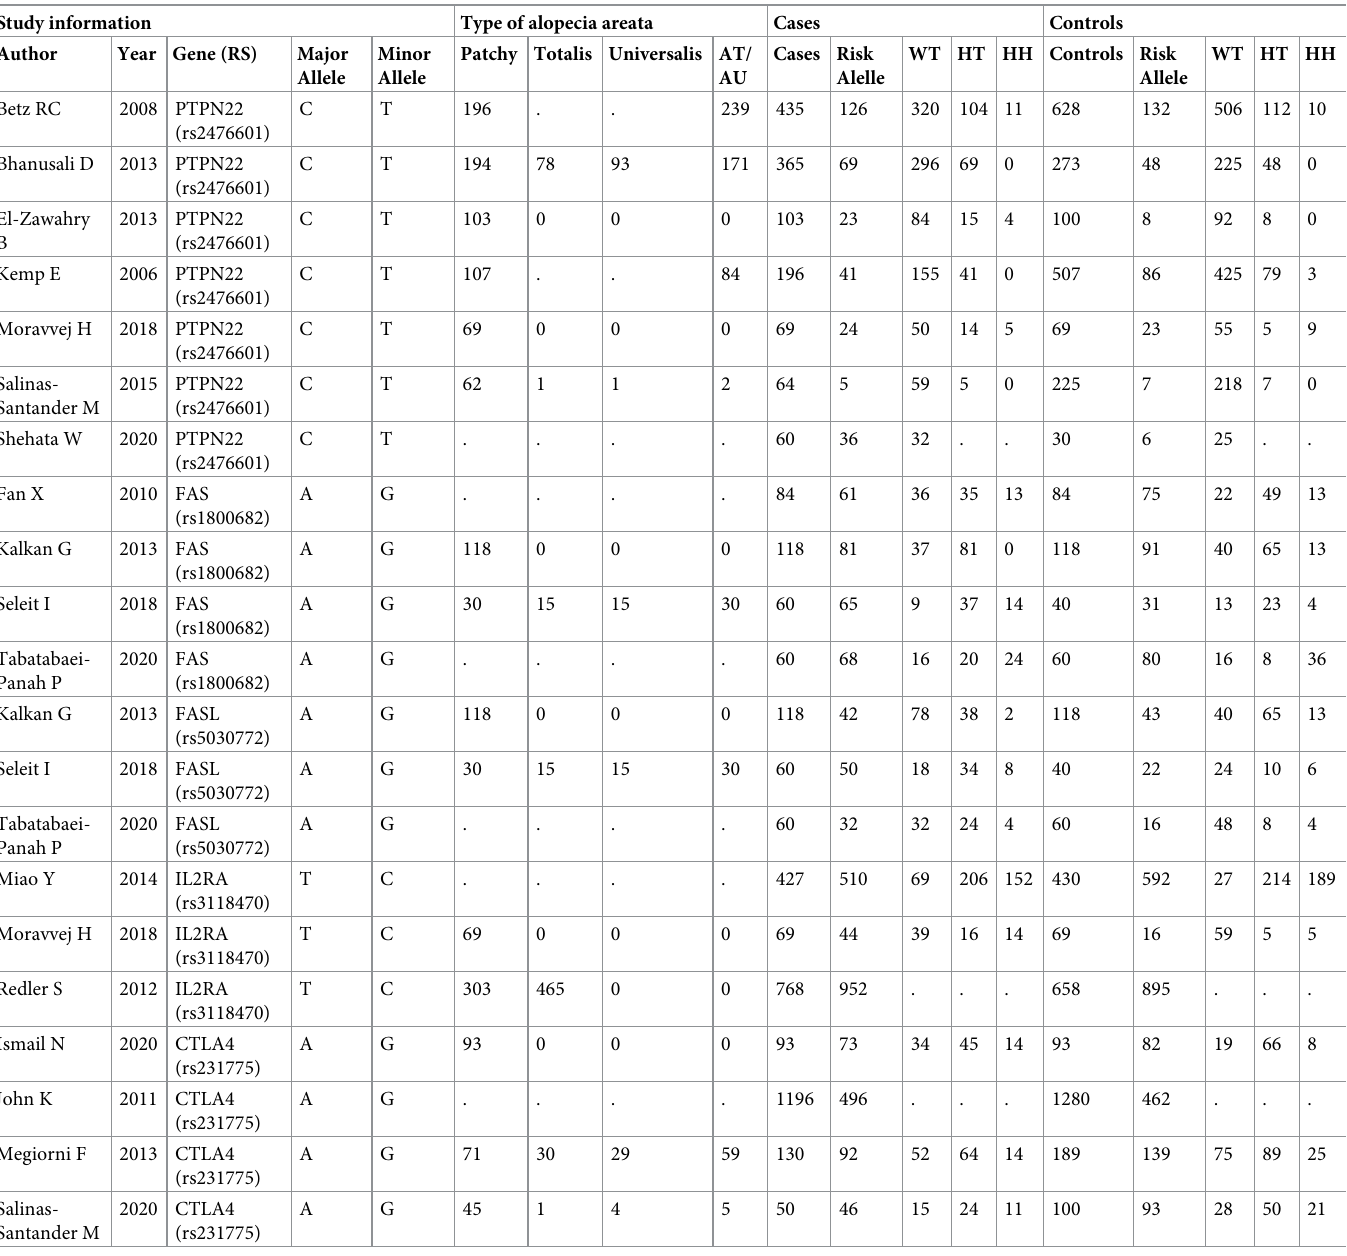
Table 3. Case-control allelic and genotypic